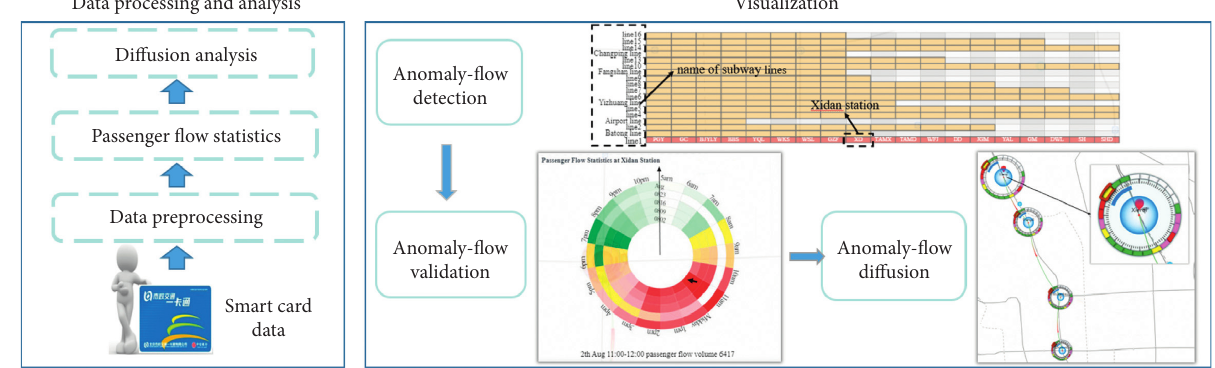
Figure 1: The workflow of our framework for analysis of anomaly